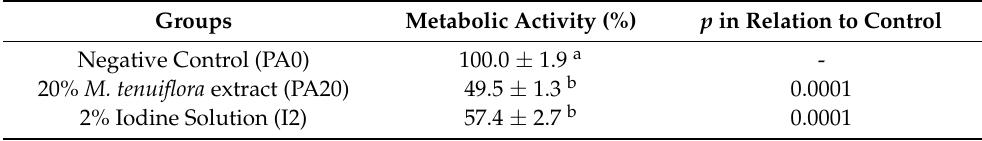
Table 3. Metabolic activity evaluated by MTT assay of domestic cat cells grown in vitro after 10 min of incubation with 20% Jurema preta ( M tenuiflora ) extract or 2% iodine. Groups